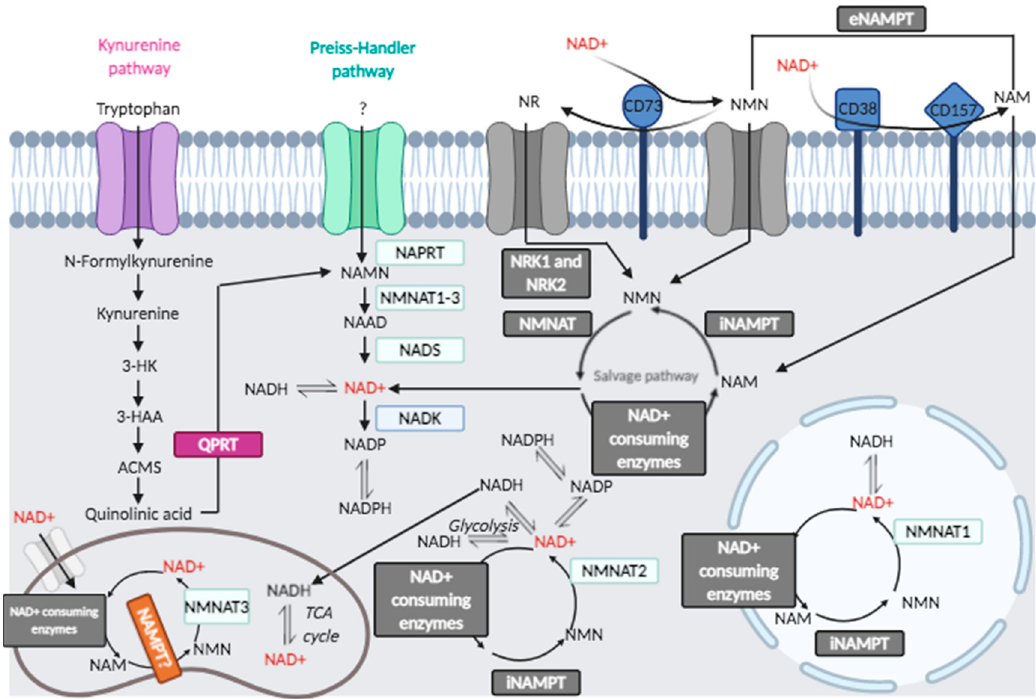
Figure 1. Cellular and extracellular NAD + metabolic pathways.